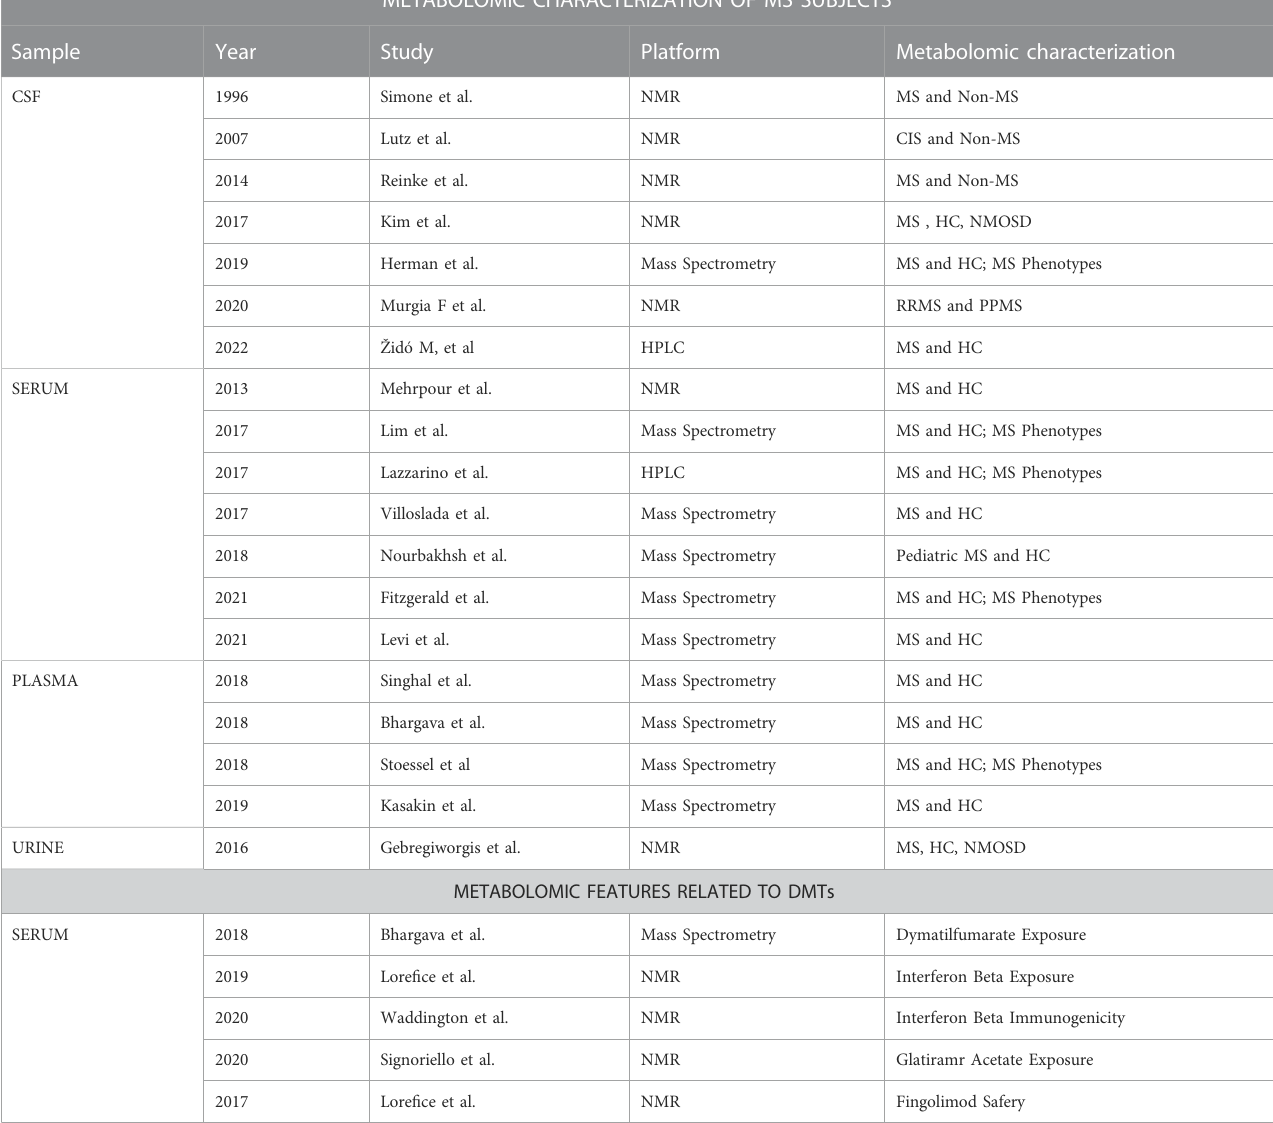
TABLE 4 Summary of metabolomics studies performed on MS patients METABOLOMIC CHARACTERIZATION OF MS